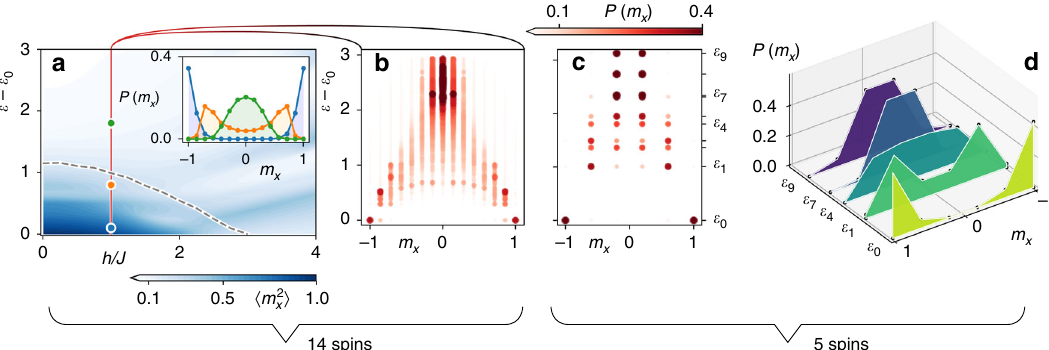
Fig. 3 Excited-state phase transition in the Ising model (3) with α = 1.5. a Ferro-paramagnet crossover in the Ising model of N = 14 spins prepared by the 1 (dark blue) to energy measurements in microcanonical ensembles of width Δ E ∕ ( JN ) = 0.1. The transition between magnetically ordered phase h ^ m 2 x i mc (cid:9) = ð JN Þ and the transverse fi eld h . An estimate of the disordered phase h ^ m 2 x i 0 (light blue) is shown as function of the mean energy density ε ¼ h ^ H i mc (cid:9) mc critical energy density in the thermodynamic limit, obtained with Monte-Carlo simulation (we use the ALPS code 55 ) of canonical ensembles of 512 spins with rescaled interactions (see Methods and Supplementary Note II), is shown as black dashed line. The inset shows the order parameter distribution P m h ∕ J = 1 and ε = 0.1, 0.8, and 1.8 in blue, orange, and green, respectively. Test of ETH (within the symmetry sector þ 1 ; (cid:2) 1 f g see Methods): x ð Þ for b order – disorder transition is seen as crossover from bi-modal distribution of P m x ð Þ at low energies to a single-peak distribution at high energies, shown on the level individual eigenstates. Color intensity and the dot size indicate the corresponding probability. c , d Qualitatively similar energy dependence of P m fi ve spins. d Signatures of the phase transition visible for representative sample of x ð Þ shown for a system of just